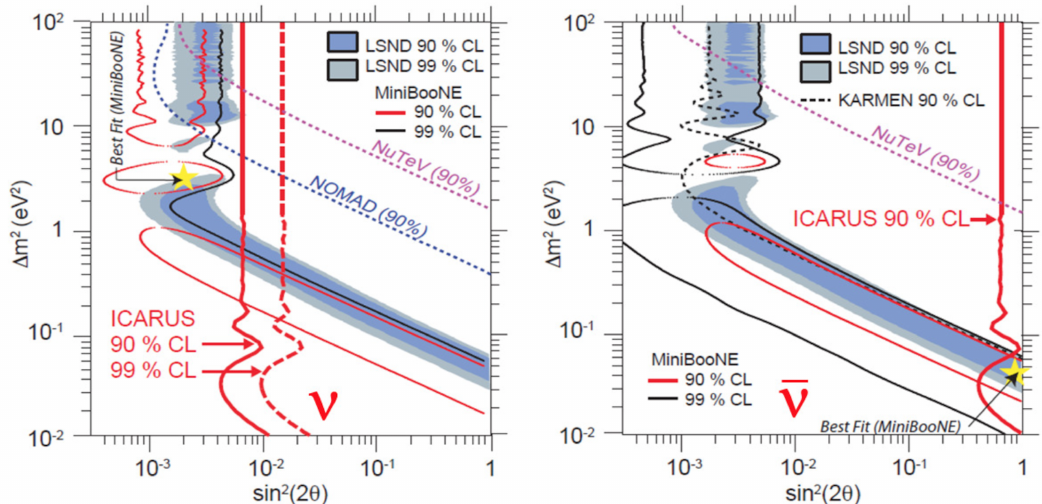
Figure 2. ICARUS-T600 exclusion plots on the search for anomalous ν µ → ν e LSND-like oscillations with the CNGS beam compared to the LSND allowed region for the neutrino ( left ) and the antineutrino ( right ) case. Other experimental limits are also shown